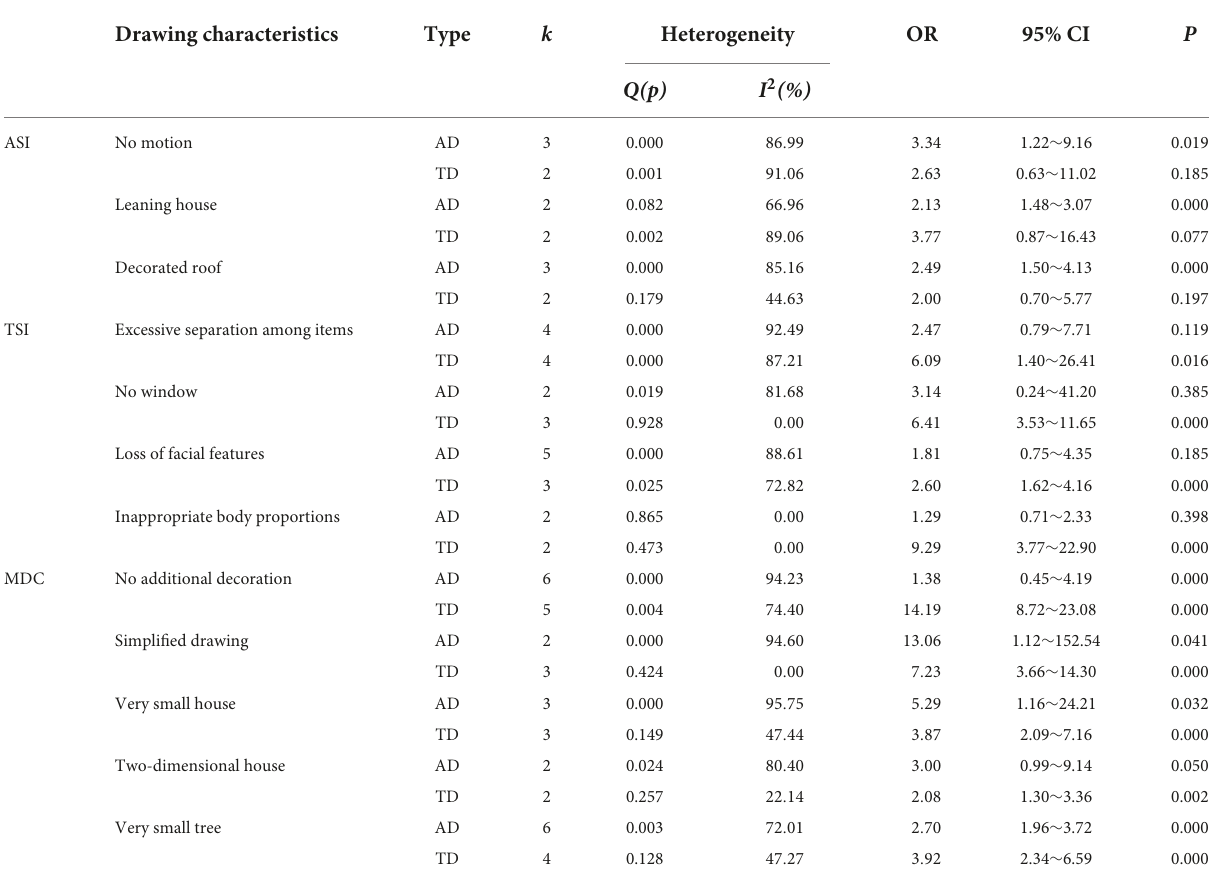
TABLE 3 Subgroup analysis of mental disorder